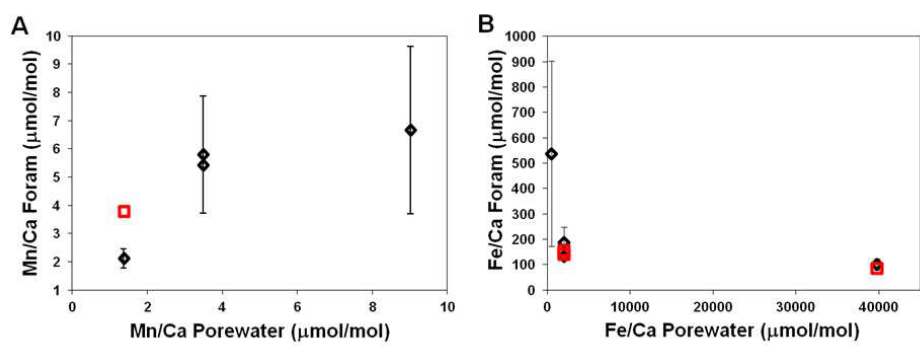
Fig. 10. Correlation between the Mn/Ca (A) and Fe/Ca (B) ratios in tests of Bolivina spissa to the Mn/Ca and Fe/Ca ratios in the top cm of the pore water from the same sampling location. Red squares indicate data points measured on bulk samples of 40 specimens with ICP-MS while black diamonds indicate mean values from single specimens measured with SIMS. Error bars on the SIMS data show the standard deviation between the different spots measured on a single